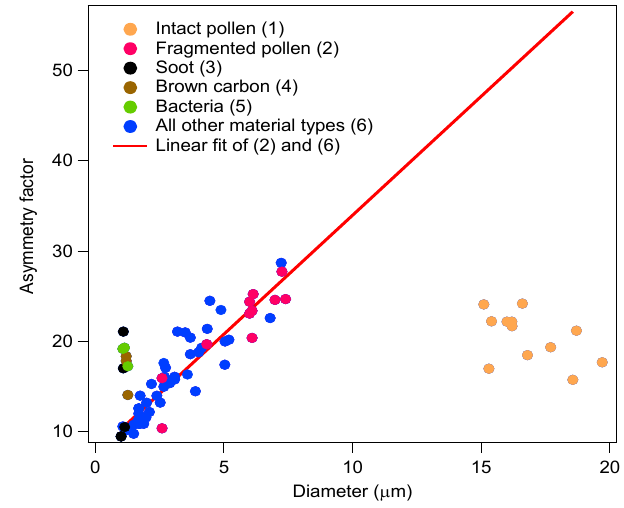
Figure 8. Median values of particle asymmetry factor versus par- ticle size for all particle types analyzed. Fitted linear regression shown, with equation y = 2 . 63 x + 7.64 and R 2 = 0.87. Linear re- gression analysis was done for samples pooled from the categories of Fragmented Pollen (2) and All Other Material Types